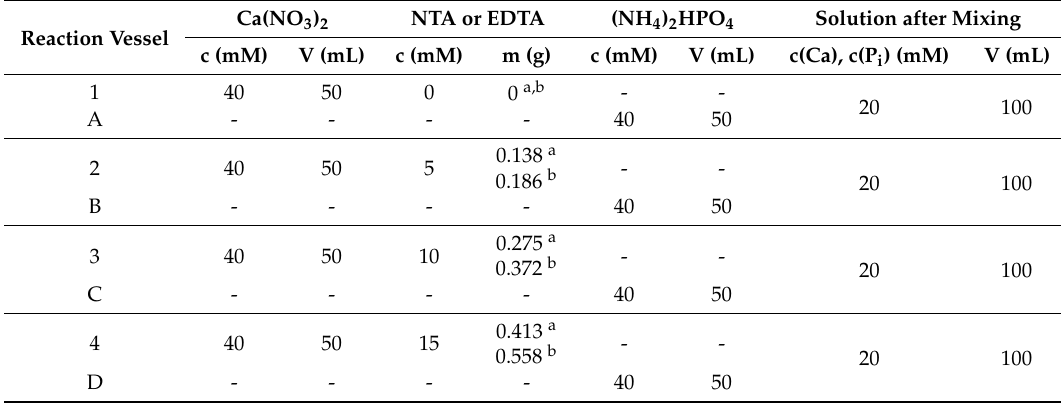
Table 1. Concentrations, masses, and volumes used for calcium phosphate (CP)